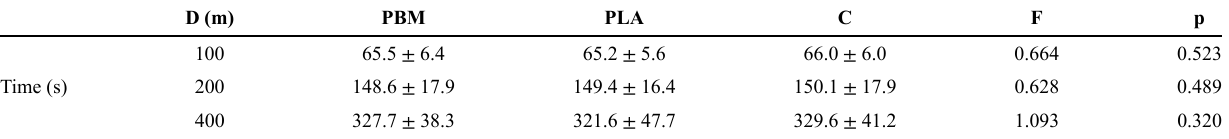
Table 2 - Mean ± SD of time to complete distances of 100-, 200- and 400-m front crawl all out on the three different